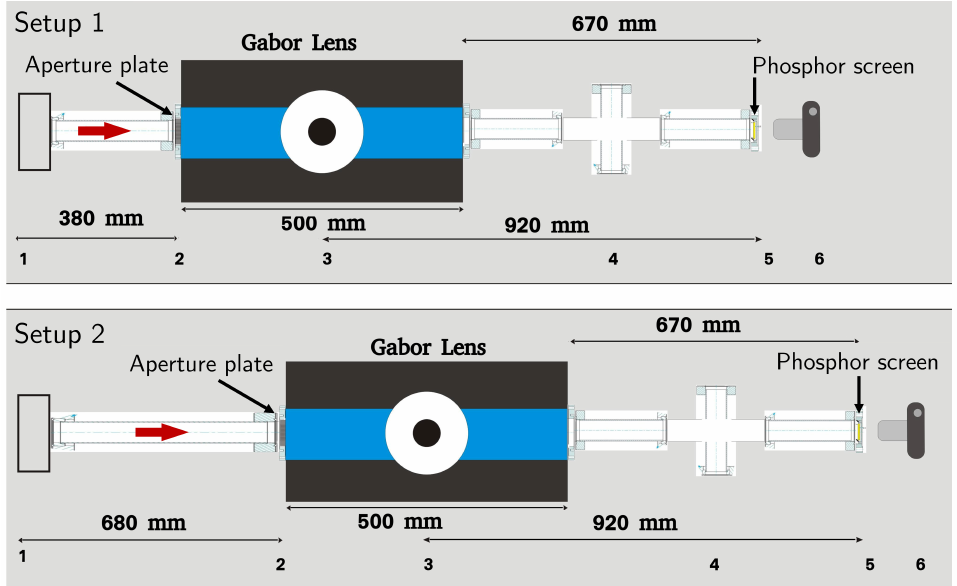
Figure 5. Schematics of the day 1 beam test setup, Setup 1 ( top ) and the day 2 beam test setup, Setup 2 ( bottom ). The setup includes the Gabor lens, aperture, and beam pipes.